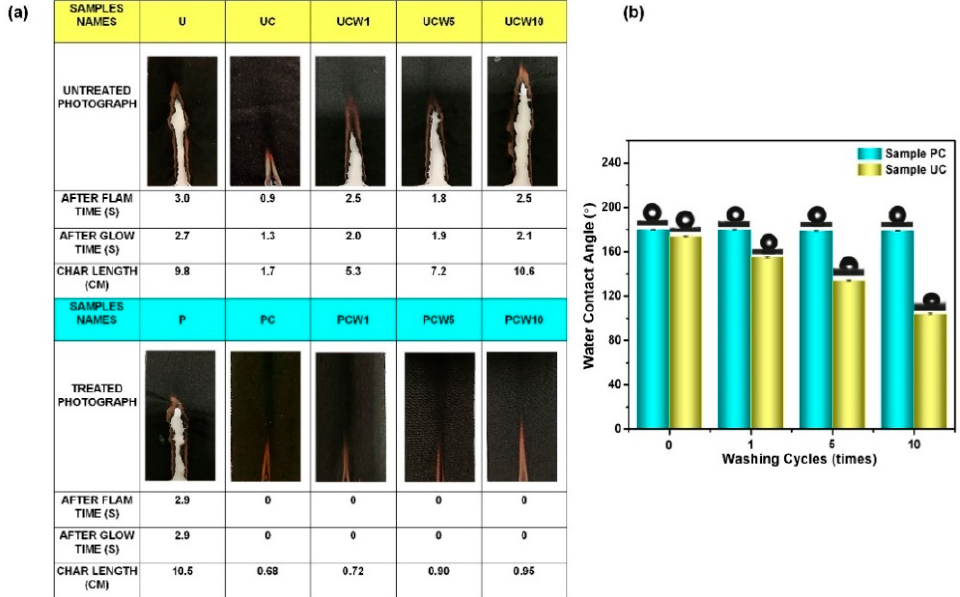
Figure 8. The vertical flammability test and water contact angles of untreated and plasma-treated after coating and repeating washing on aramid fabric surfaces: ( a ) vertical flammability standard photographs on untreated and plasma-treated fabrics, respectively, ( b ) water contact angles and their corresponding graph vs. washing cycles.